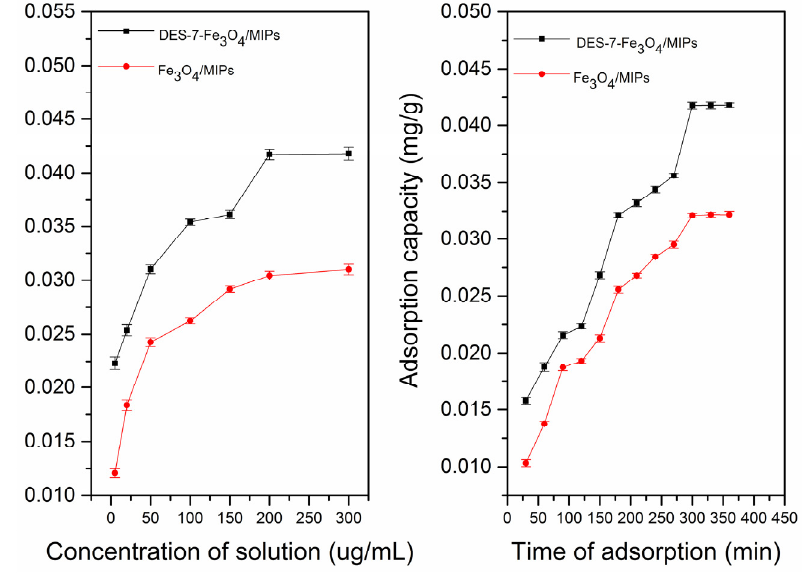
Figure 5. The static and dynamic adsorption capacity curves of two materials (Fe 3 O 4 /MIPs, and DES-7-Fe 3 O 4 /MIPs) for Theophlline.